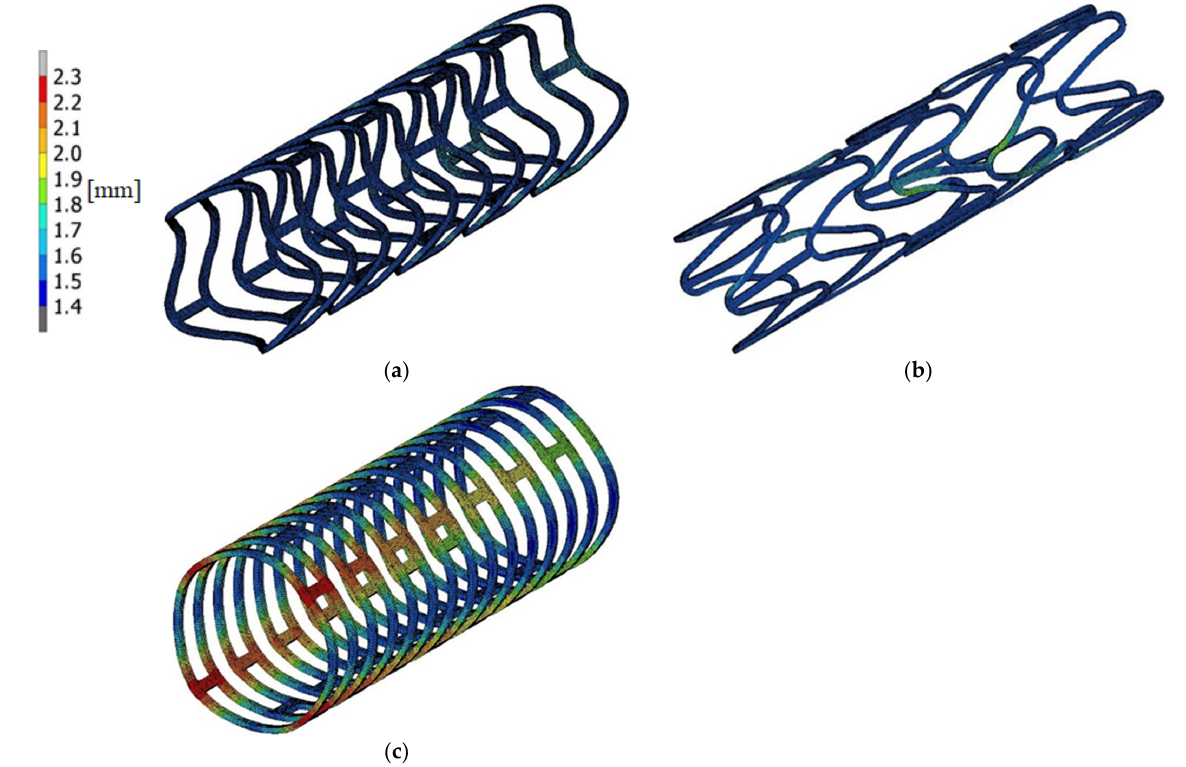
Figure 7. The deformation state after deployment for stents: ( a ) optimal, ( b ) too long, ( c ) too short .